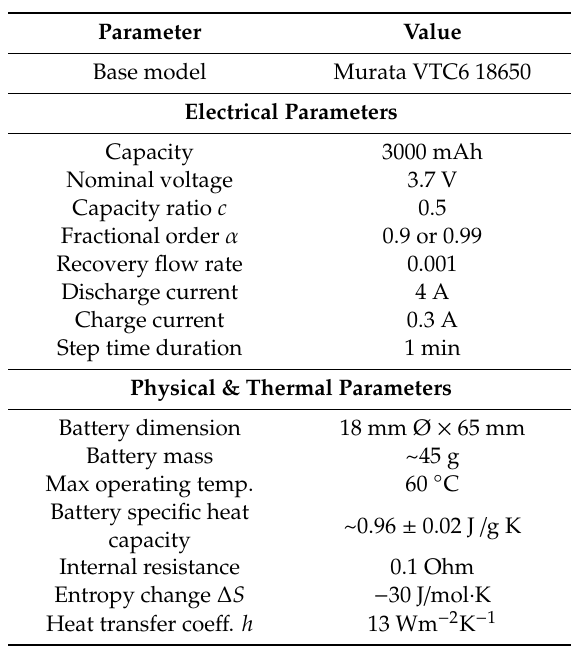
Table 1. The parameters of the lithium-ion battery model used in the work.